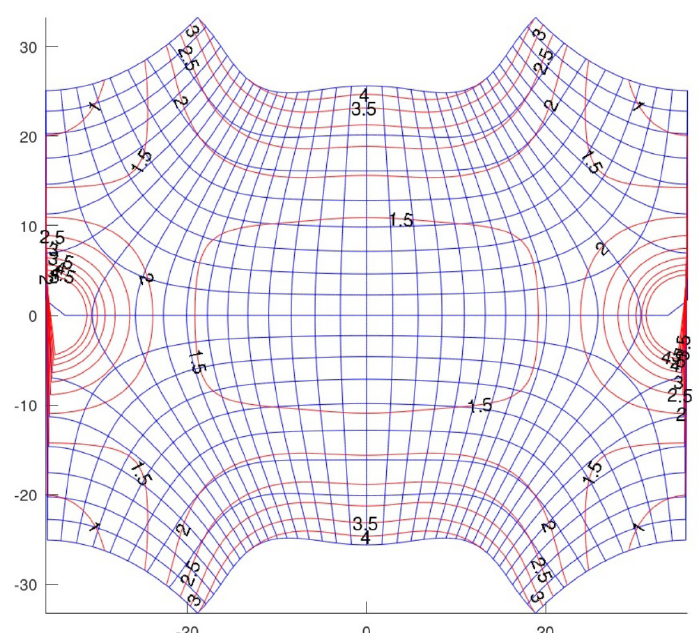
z of the function 8 sin 8